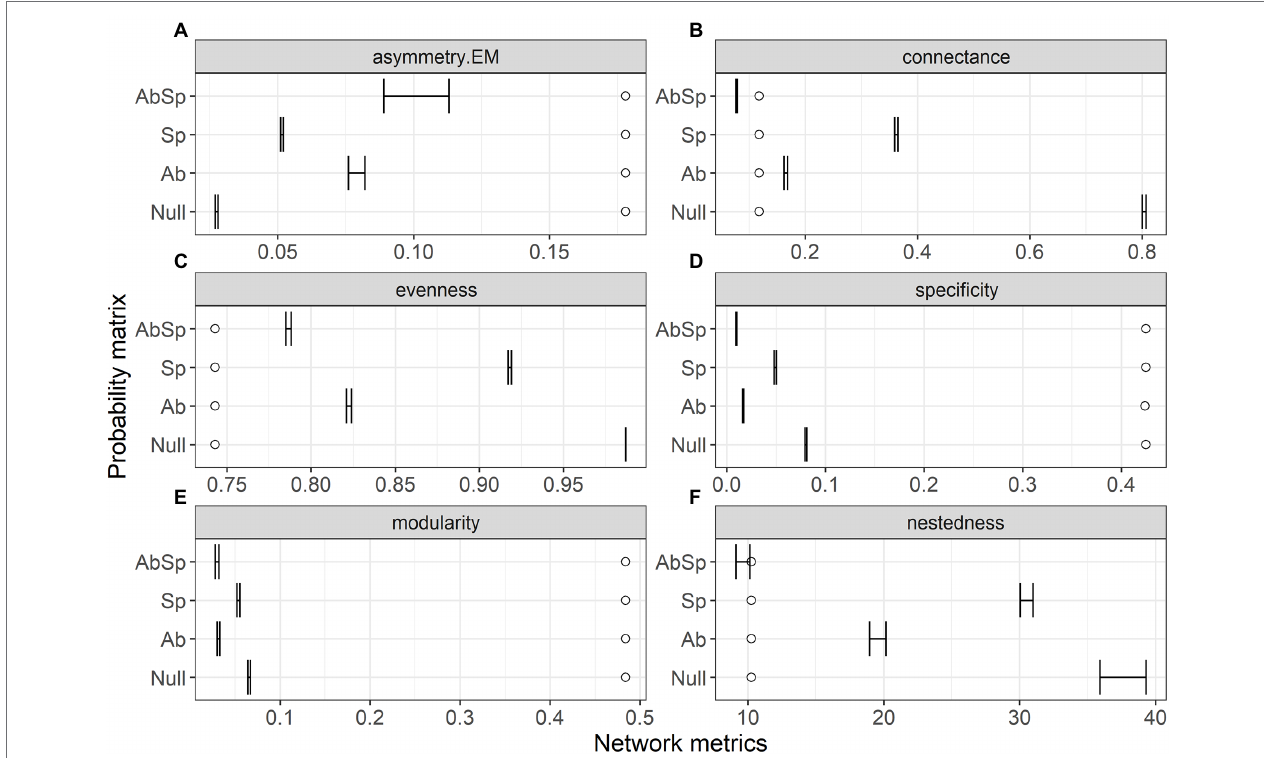
FIGURE 2 | Comparison of the network metrics produced by probability matrices (95% confidence intervals) and the observed network values for the plant– ectomycorrhizal fungal network. Network metrics include interaction asymmetry for ectomycorrhizal fungus (asymmetry. EM, A ), network connectance (B) , network evenness (C) , network specificity (D) , network modularity (E) and network nestedness (F) . Network metrics are shown at the top of each panel, with circles showing the observed value and lines showing the 95% confidence intervals in the predicted values. Results are shown for the three probability matrices calculated from abundance (Ab), spatial overlap (Sp), and their interaction (AbSp) and a null matrix with homogeneous interaction probabilities across all pairwise interactions